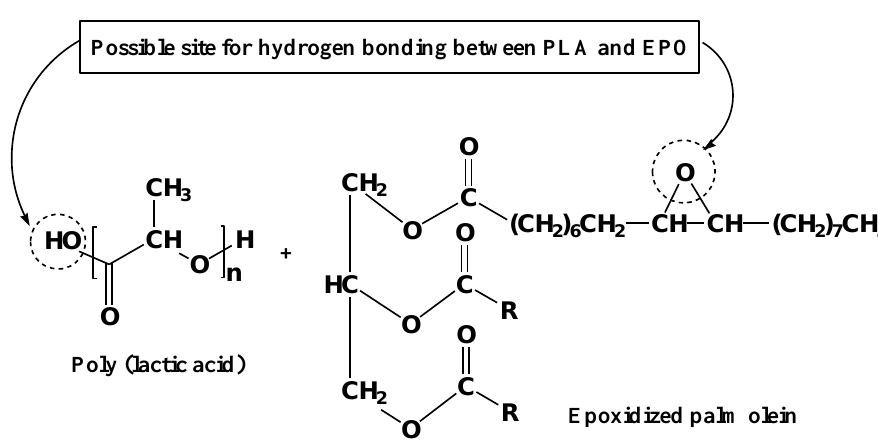
Figure 7. Proposed chemical interactions between PLA and